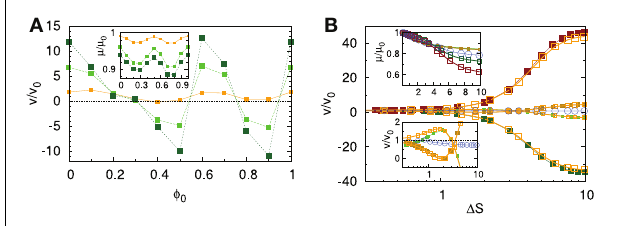
FIGURE 6 | Confinement modulated velocity for a Brownian motor moving due to an asymmetric flashing ratchet in a symmetric channel. (A) Normalized particle velocity, in units of v 0 = v ((cid:3) S = 0 ) , upon variation of the phase shift φ 0 for different values of the parameter (cid:3) S = 0 . 84 , 2 . 19 , 2 . 94 (the larger the symbol size, the larger (cid:3) S ), for V 1 = 0 . 2 and Q = 2. Inset: μ , in units of the dimensionless mobility, μ 0 , as a function of φ 0 for the same parameters. (B) Normalized particle velocity upon variation of (cid:3) S as obtained by varying particle radius R (solid lines, with h 1 = 1 . 25 , h 2 = 0 . 2), h 1 (solid points, with R = 1 , h 2 = 0 . 2) or h 2 (open points, with R = 1 , h 1 = 1 . 25) for φ 0 = 0 . 2 , 0 . 3 , 0 . 5 , 0 . 6 and V 1 = 0 . 2 , Q = 2 (the larger the symbol size, the larger φ 0 ). Cyan open circles represent the average velocity obtained by a uniform distribution of φ 0 as a function of (cid:3) S . Inset: μ / μ 0 as a function of φ 0 for the same parameters. Reprinted with permission from (59). Copyright (2013) by the American Physical